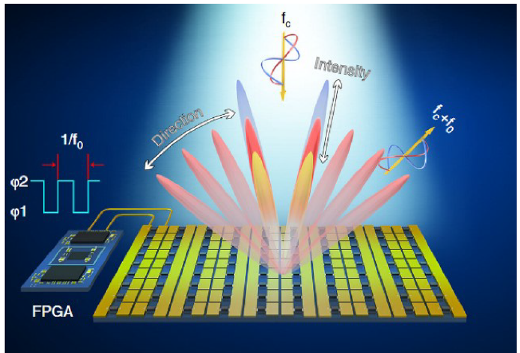
Figure 29: Schematic diagram of the time-domain digital coding metasurface [130]. Reprinted from [130], with the permission of Springer Nature Publishing. © 2018, The Author(s).